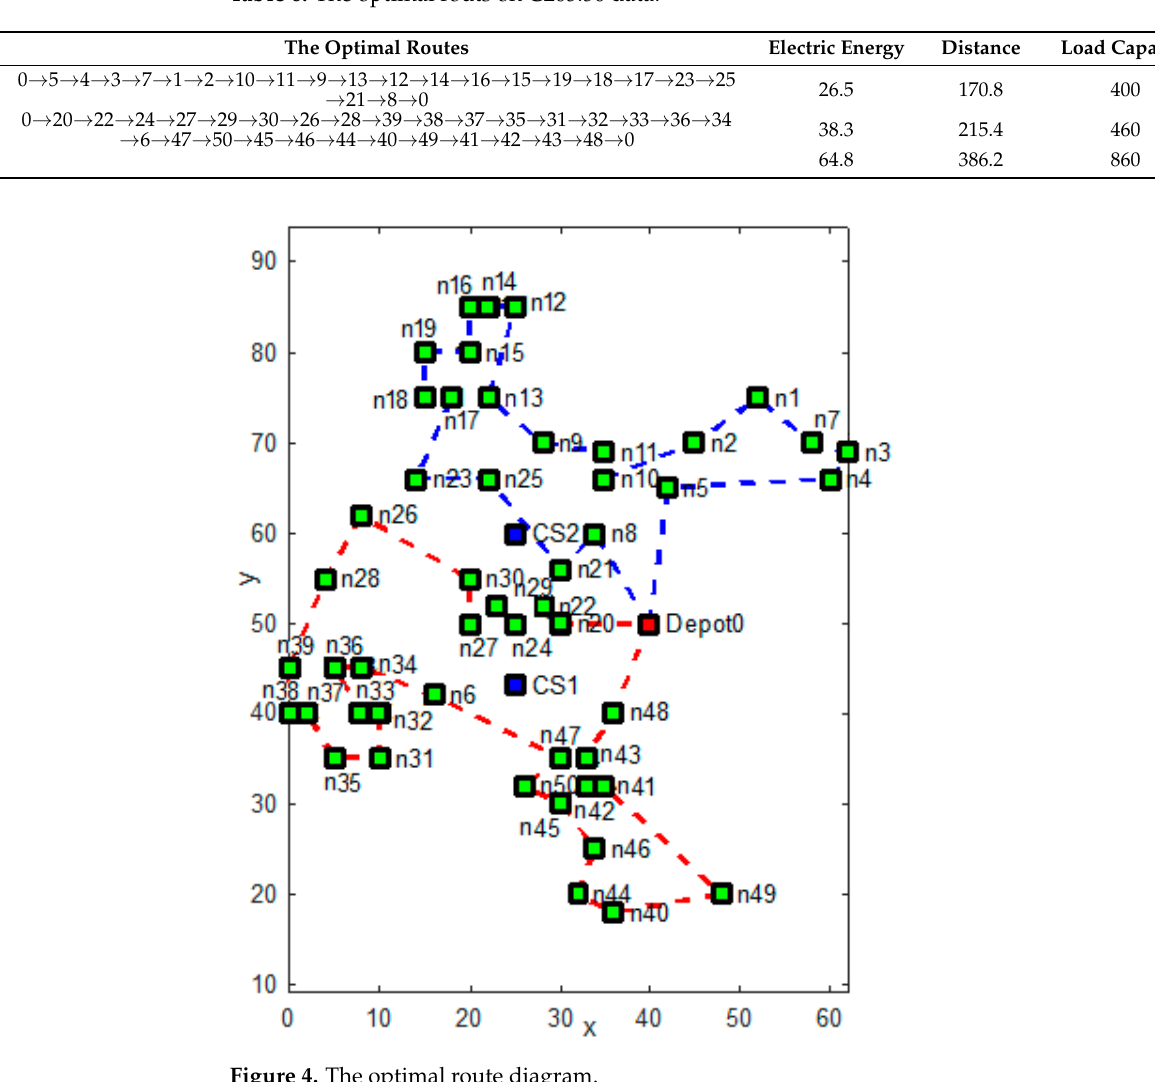
Figure 6. New partial route of route 2. The customer 5, 20, 22, and 24 are close to the depot with early time windows as shown in Table 2 and Figure 4. They are set as the priority served customers in optimal route 1 and route 2 for reducing the punishment cost. The optimal routing schedule is reasonable and applicable. 6. NR-EGA Application to Hiland Dairy Delivery Service To testify the applicability of the NR-EGA, the paper discusses the delivery schedules of the Hiland Dairy milk delivery service in Dallas, Texas, USA. Figure 7 shows the coor- dinates of the depot of the Hiland Dairy, two EVgo Charging stations and 33 customers in the google map. The customers are randomly distributed in [0–100 km, 0–100 km] re- gions with loose time window as [0, 24 h]. The Hiland Dairy uses EVs with constant speed 50 km/h to carry out the milk delivery. The EV’s service time at each customer is set as 10 min. The EV’s recharged time at the EVgo Charging Station is set as 40 min. The routing parameters are shown in Table 7. With 100 population, the NR-EGA carries out 500 optimizing iterations to find the optimal route. The performance results are shown in Table 8 and Figure 8. In the Figure 8, the NR-EGA designs two EV to carry out the milk delivery service. As the electric energy capacity of the EV is 30 kwh, each EV has once electric recharging at EVgo charging stations. Their total electric energy and total travel distances are shown in Table 8. In the table, the first EV consumes more electric energy and needs more time for the delivery service. Including the recharging time, the first EV takes 9.5 h to carry out the delivery service for 17 customers, while the second EV takes 7.6 h for 16 customers. Table 7. Routing parameters in NR-EGA. Parameter